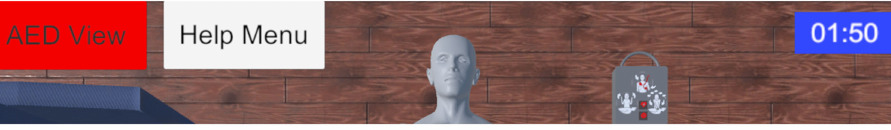
Figure 2. AED simulation timer.